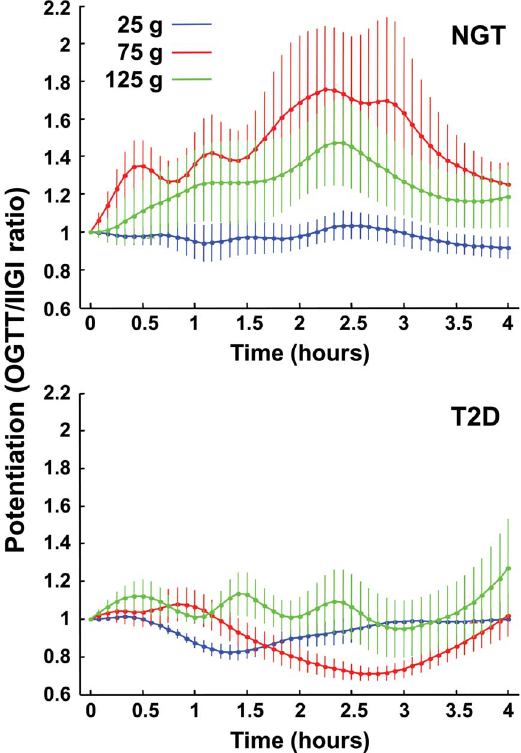
Figure 4. Incretin effect on potentiation. Time-course of the incretin effect on OGTT/IIGI ratio of the potentiation factor with increasing glucose loads in NGT and T2D participants. The potentiation factor is normalized to the baseline value before calculating the ratio. Plots are mean 6 SE.